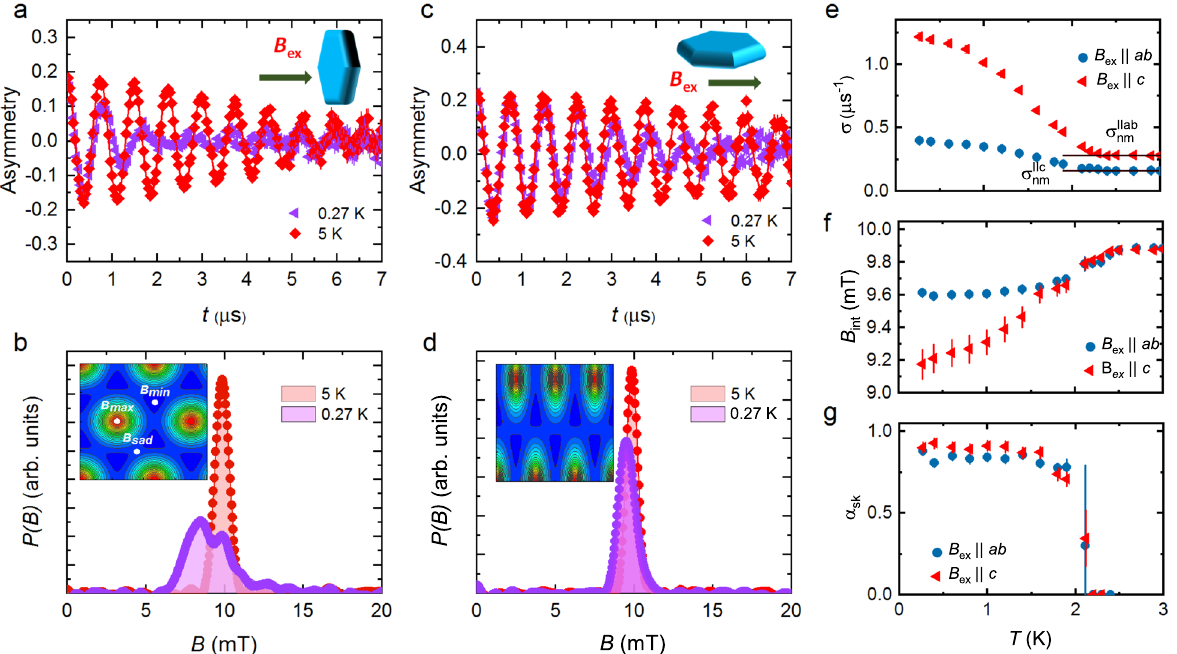
Fig. 2 Results of TF- μ SR experiments. a and c TF- μ SR spectra collected above and below T c for CsV 3 Sb 5 with B ext ∣∣ c and B ext ∣∣ ab , respectively. The fast damping of the signal in the superconducting state re fl ects the inhomogeneous fi eld distribution sensed by the muon ensemble as a result of vortex formation. Solid lines through the data points are fi ts using Eq. (5) in the Suppl. Inset: Scheme of the setup for μ SR experiments on a single crystalline CsV 3 Sb 5 sample. b and d show the Fourier spectra obtained by fast Fourier transformation of the spectra in a and c , respectively. The inset shows the spatial fi eld variation within a fl ux line lattice of an anisotropic superconductor with an anisotropy parameter γ λ ≃ 3, as explained in detail in Refs. 72,75 . The cutoff at low fi elds corresponds to the minimum in P ( B ) occurring at the midpoint of three adjacent vortices ( B min ). The peak in P ( B ) arises from the saddle point midway between two adjacent vortices ( B saddle ), whereas the long tail towards high fi elds is due to the region around the vortex cores ( B max ). e Temperature variation of the square-root of the second moment ], as measured for the two applied fi eld directions. The horizontal lines denote the relaxation due to nuclear of fi eld distribution σ ( T ) [ σ ¼ M 1 = 2 2 magnetic moments along the two directions. f Internal magnetic fi eld as a function of temperature in the superconducting state. A clear diamagnetic shift, an immanent feature of type-II superconductors, can be seen. g Temperature variation of the skewness parameter, 1 = 3 = M 1 = 2 α , for the B ext ∣∣ c and B ext ∣∣ ab set of experiments. The error bars represent the SD of the fi t sk ¼ M 3 2 exactly this effect. Note that the measured distribution of the magnetic fi elds in the superconducting state becomes asym- by horizontal lines in Fig. 2e]. As shown in Fig. 2f, for both fi eld metric, as expected for a well-arranged FLL. All the characteristic orientations the fi rst moment — which represents the internal fi eld features, as e.g., the cutoff at low fi elds ( B min ), the peak due the ( B int ) — shows a clear diamagnetic shift below T c , as expected for a saddle point between two adjacent vortices ( B sad ), and the long type-II superconductor. Note that the T c value estimated from μ SR tail towards high fi elds, related to the regions around the vortex experiments agrees with that determined from magnetization core ( B max ), are clearly visible for B ext ∣∣ c . However. the asymmetric measurement, so that T μ SR ¼ T χ ’ 2 : 5 K. c c The asymmetric line shape of the fi eld distribution P ( B ) is shape is not observed in case of B ext ∣∣ ab for two reasons: (i) Long λ λ leads to smaller fi eld variation within the vortex lattice. characterized by the third moment ( M 3 ) of the fi eld distribution (see c : long (ii) High value of the nuclear moment contribution σ nm : since the Suppl. Mater. for the calculations) and has three characteristic fi elds: B min , B max , and B sad . More accurately, the asymmetry of the line asymmetric line shape caused by the formation of the vortex = M 1 = 2 lattice needs to be convoluted with σ nm37 , which effectively leads shape is described by its skewness parameter α sk ¼ ð M 1 = 3 Þ , 3 2 to a smearing out the characteristic features of the vortex lattice. which assumes a value of 1.2 for a perfectly arranged triangular The locations of B min , B sad , and B max are shown in the contour plot vortex lattice 38,39 . Distortions or even melting of the vortex lattice in the inset of Fig. 2b. To account for the fi eld distribution P ( B ), the structure, which may be caused by variations of temperature or time-domain spectra were analyzed using a skewed Gaussian magnetic fi eld, are strongly re fl ected in α sk40 – 42 . (SKG) function, which represents the simplest distribution Figure 2 (g) shows the temperature evolution of α jj c (for B ext ∣∣ c ) sk accounting for the asymmetric lineshape (see Suppl. Mater. for a and α jj ab (for B ext ∣∣ ab ) for the kagome superconductor CsV 3 Sb 5 . sk detailed description of the function). Notably, in both directions, α sk ( T ) remains independent of The parameters obtained from the fi ts are presented in temperature for T ≲ T c , with a constant value of ≃ 0.8 for α jj ab sk Fig. 2e – g. Figure 2e shows the temperature dependence of the and 0.9 for α jj c , respectively. We note that near the super- sk square root of the second moment M 2 (see Suppl. Mater. for conducting transition temperature the μ SR response could be well fi tted by the single Gaussian line (i.e., the reduced χ 2 of SKG and detailed calculations) which corresponds to the total depolariza- tion rate σ for two fi eld orientations. Below T c , the relaxation rate σ single Gaussian fi ts become almost equal). Since for the symmetric P ( B ) distribution α sk stays exactly at zero, this leads to the sudden starts to increase from its normal-state value due to the formation of the FLL and saturates at low temperatures. The normal-state change of α sk at T ~ 2.2 K , i.e., ≃ 0.3 K below T c . This observation muon depolarization rate is mostly due to the nuclear magnetic suggests that very close to T c , the FLL is slightly distorted but does moments and, for CsV 3 Sb 5 , it has different values for the two fi eld not disturb the determination of the temperature evolution of the